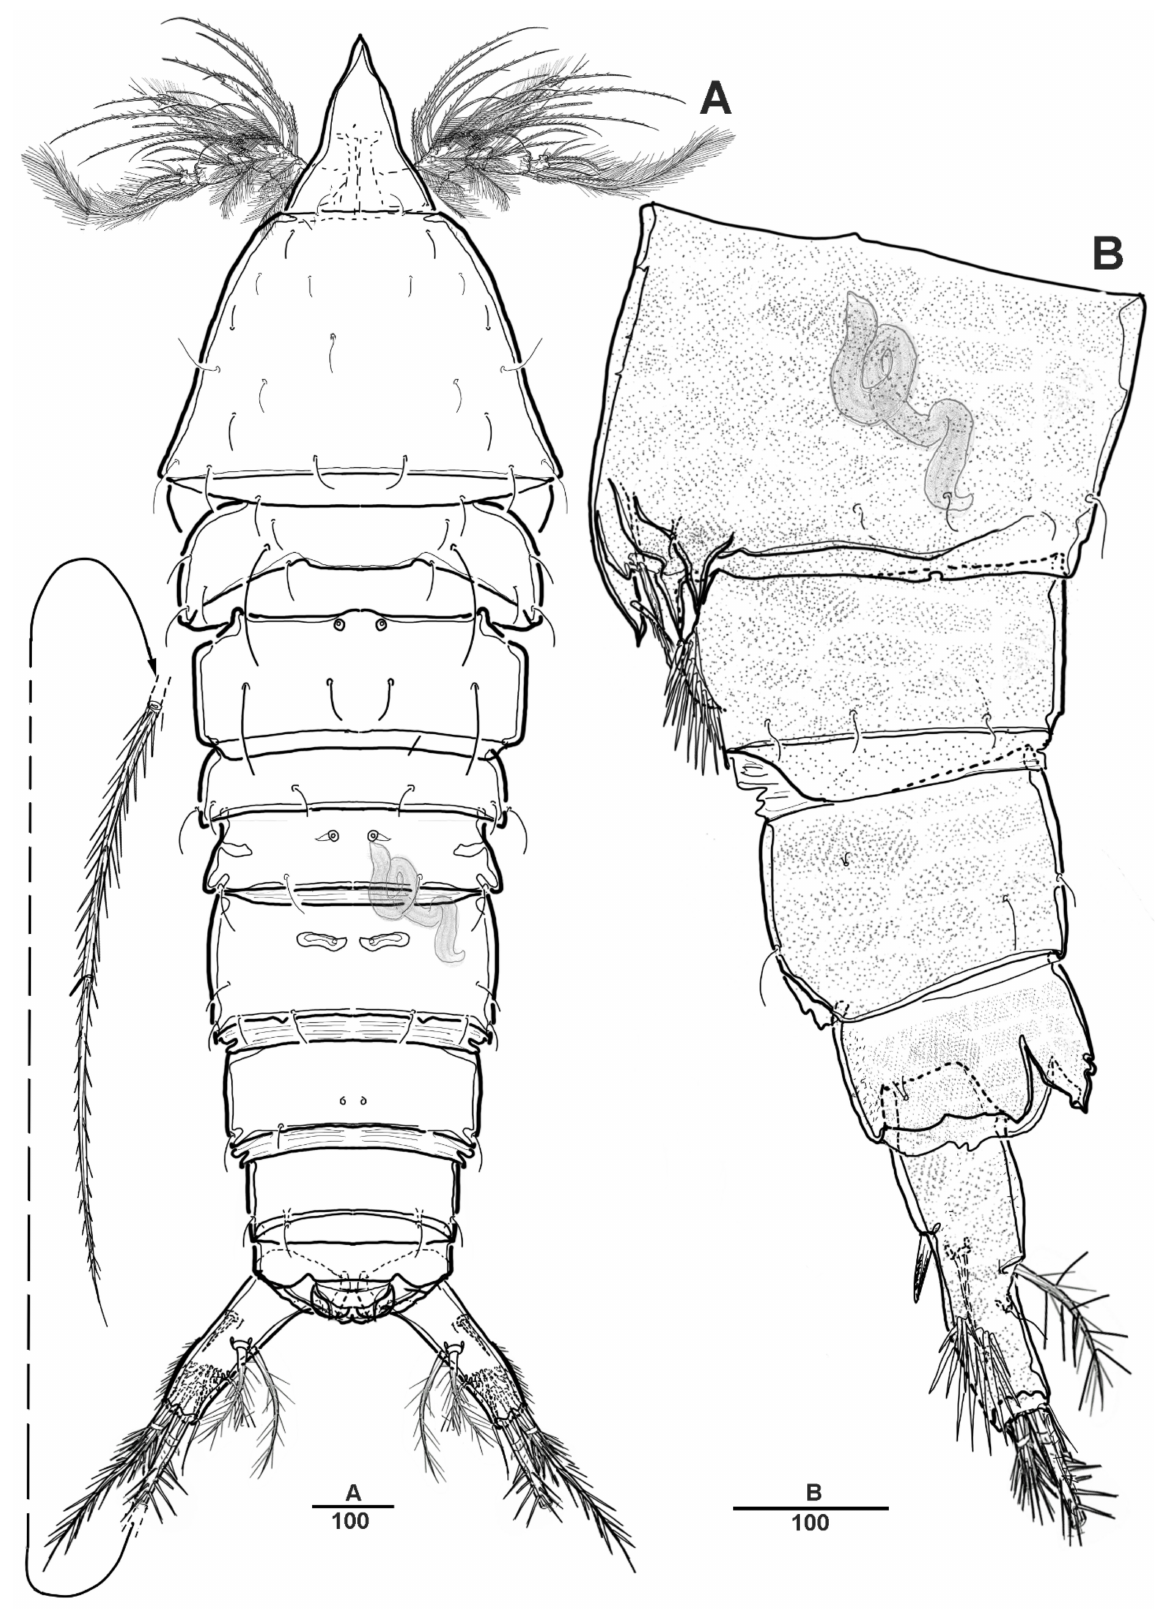
Figure 8. Scottolana daecheonensis sp. nov. paratype male: ( A ) habitus, dorsal; ( B ) urosome, lateral. Scale bars in µ